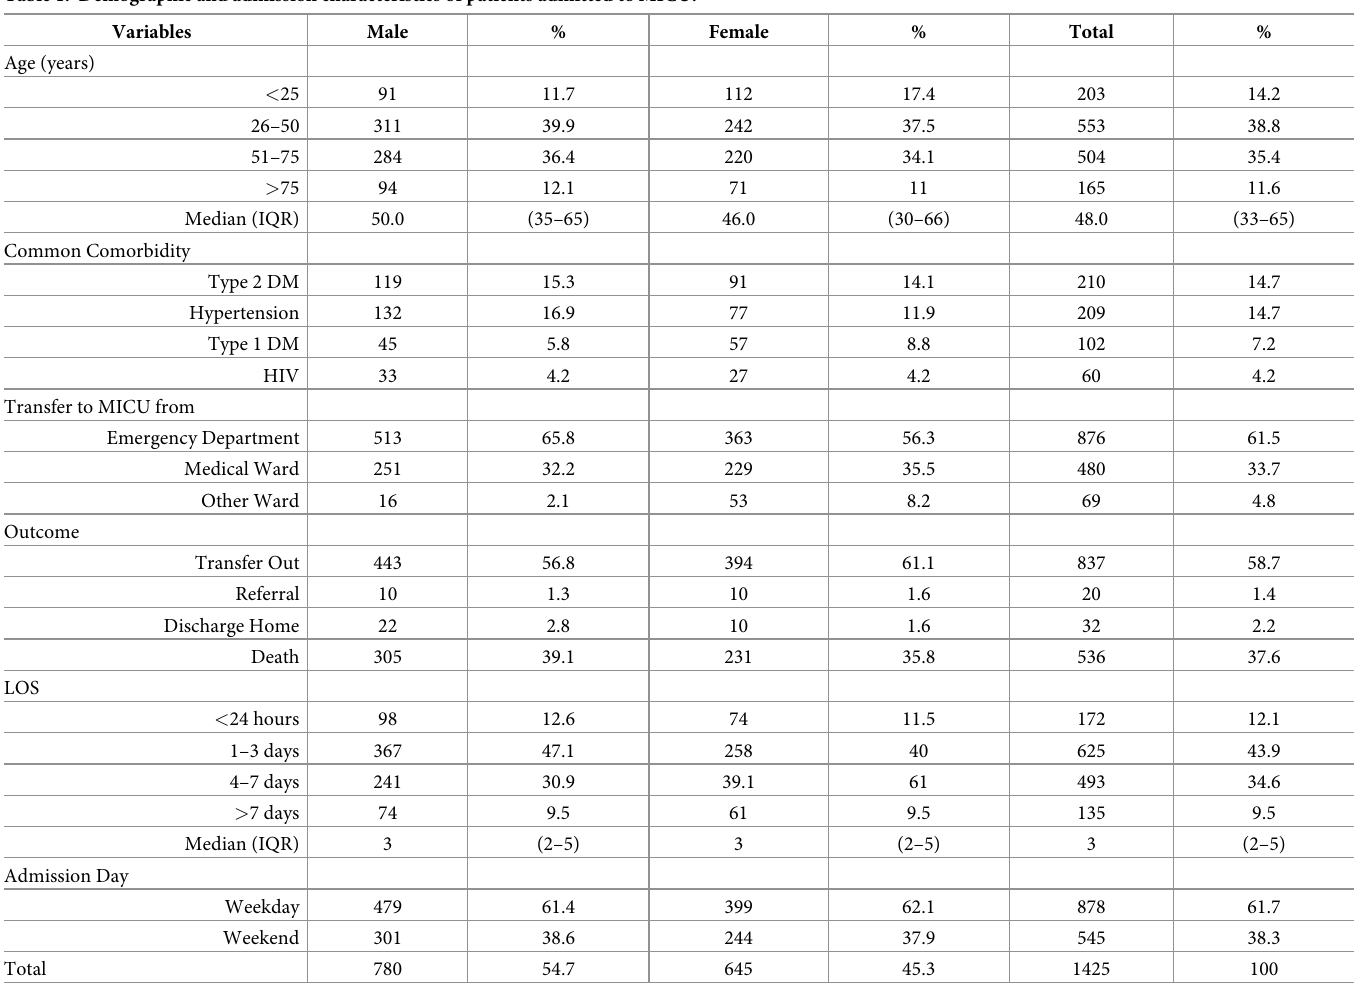
Table 1. Demographic and admission characteristics of patients admitted to MICU.